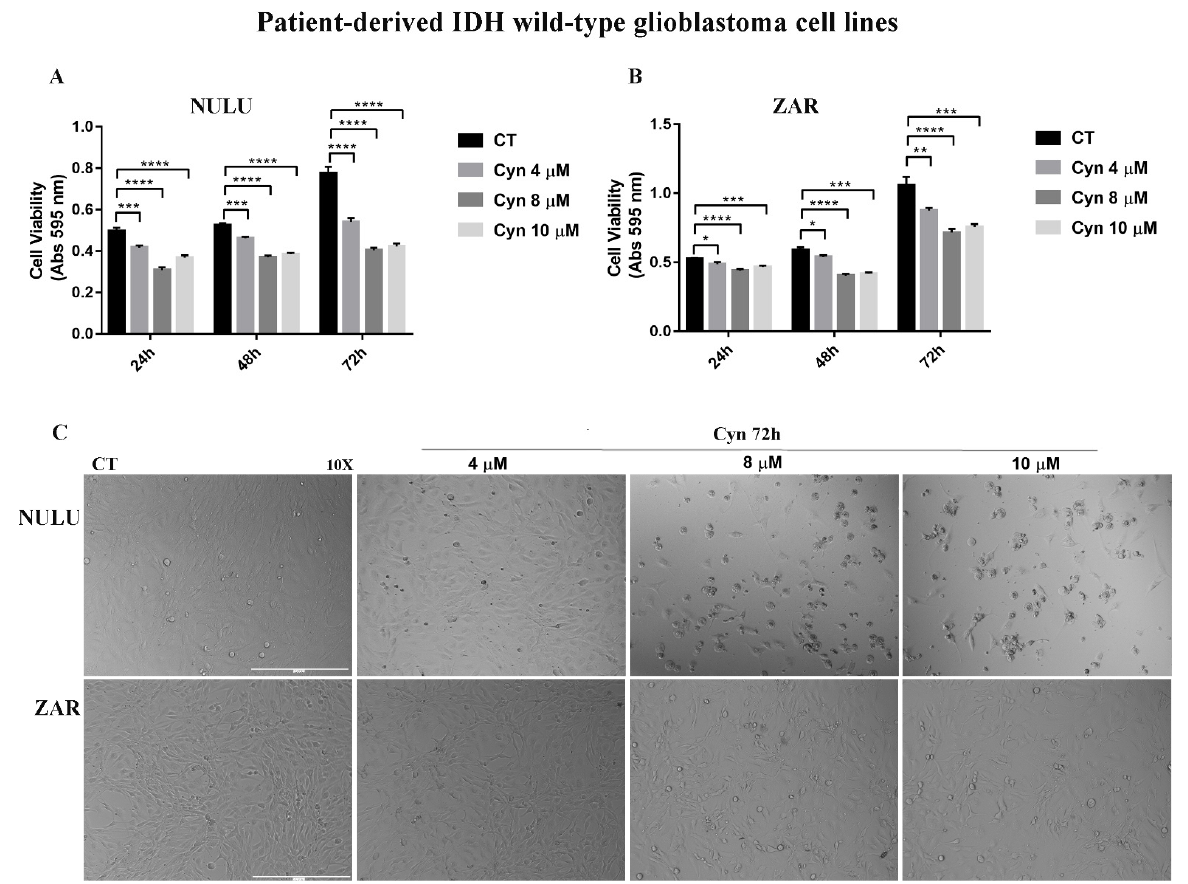
Figure 8. Cytotoxic effects of Cyn on patient-derived glioblastoma cell lines NULU and ZAR. ( A ) Cytotoxic effects of daily exposure to Cyn 4, 8 and 10 µ M for 24, 48 and 72 h on NULU ( A ) and ZAR ( B ) cell metabolism. DMSO 0.1% was used as the vehicle control. ( C ) Morphological changes for